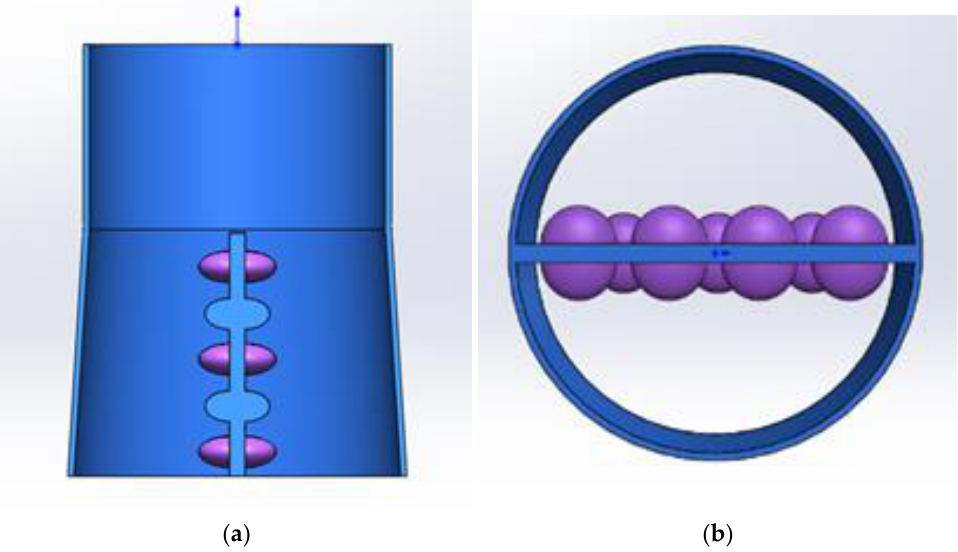
Figure 7. ( a ) The cross-sectional drawing of the sprinkler head; ( b ) The vertical view of the sprinkler